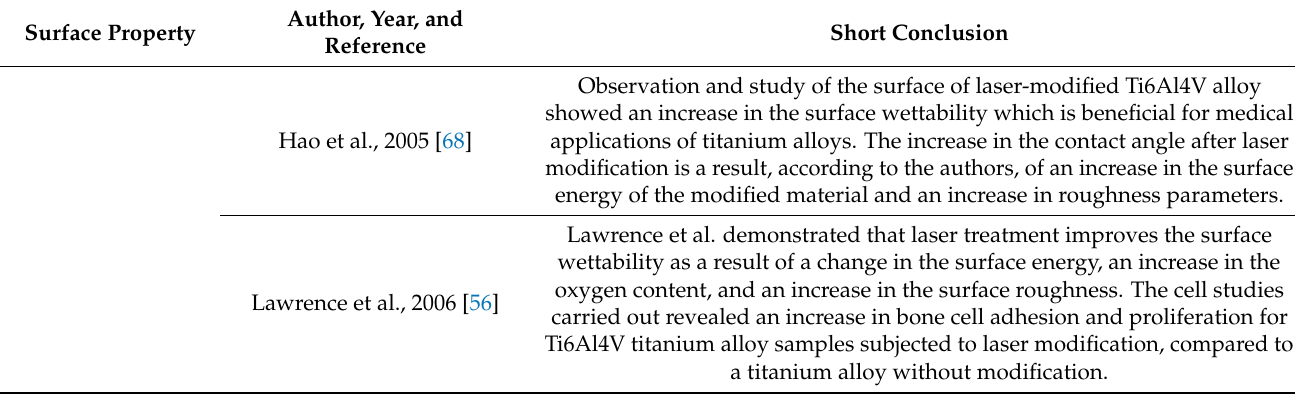
Table 3. Wettability results on titanium and its alloys observed in the